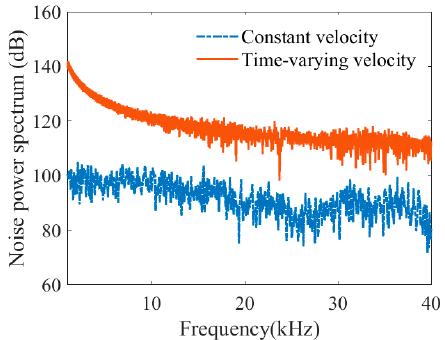
Figure 13. Flow noise power spectrum under different inflow conditions.